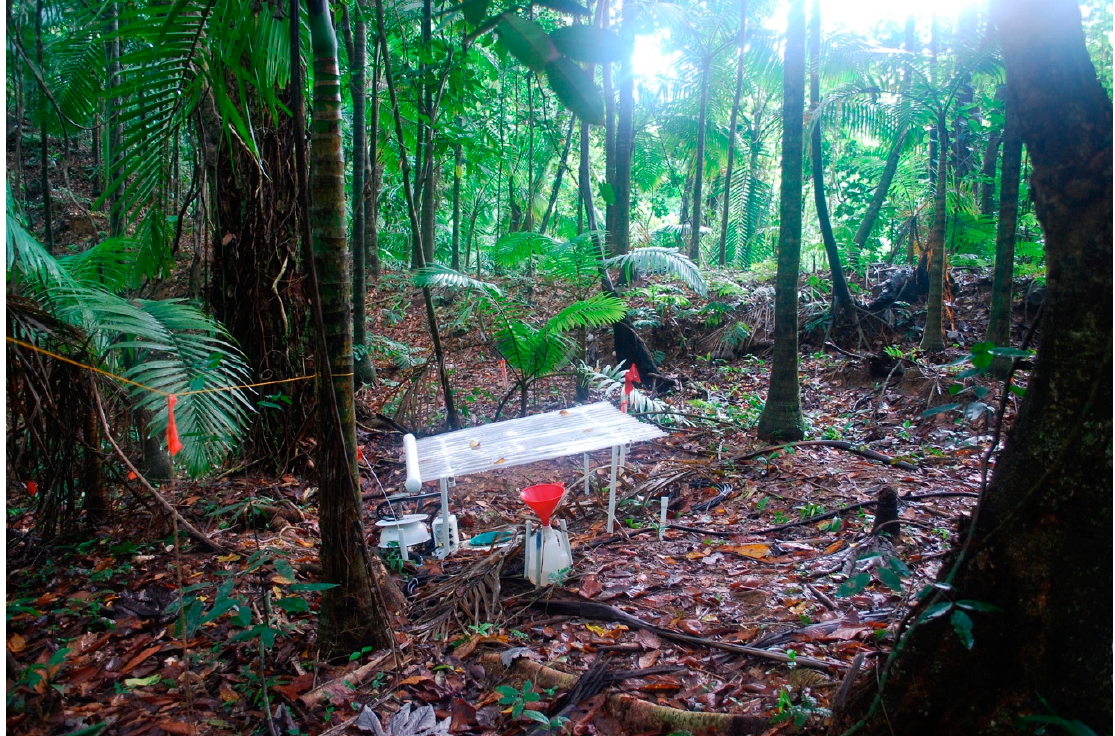
Figure 5. Throughfall exclusion shelter installed in the Luquillo Experimental Forest. Photograph by 456 Tana E. Wood. 457